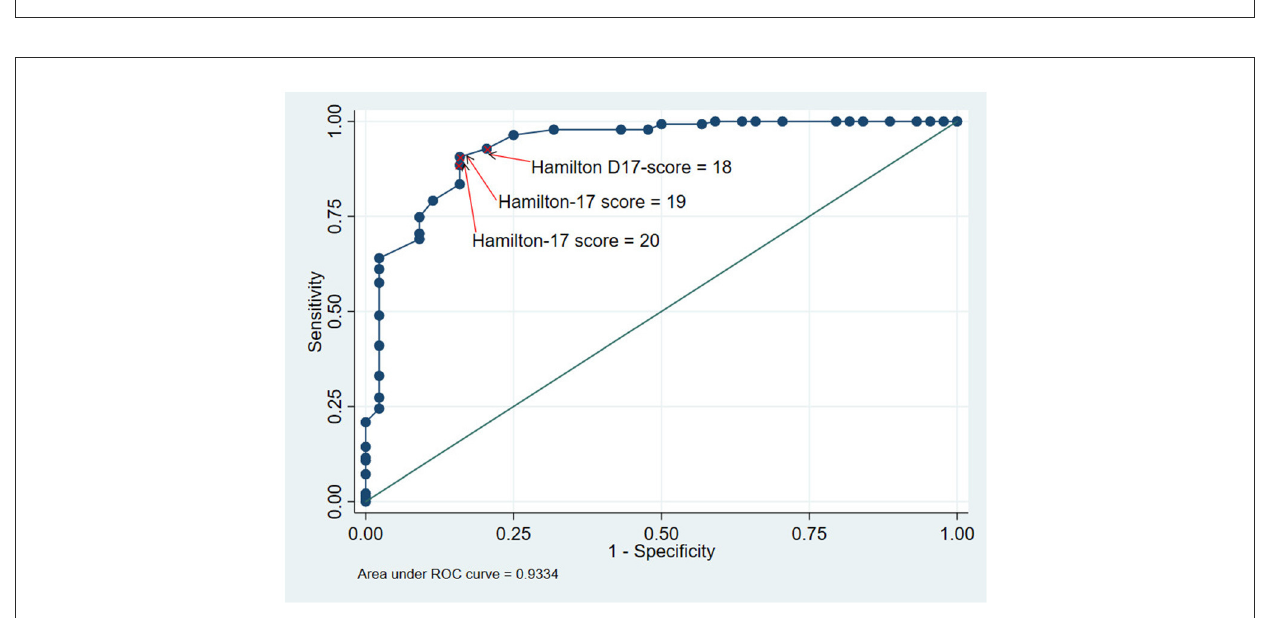
FIGURE4 ROC curve of the Vietnamese version of the Hamilton